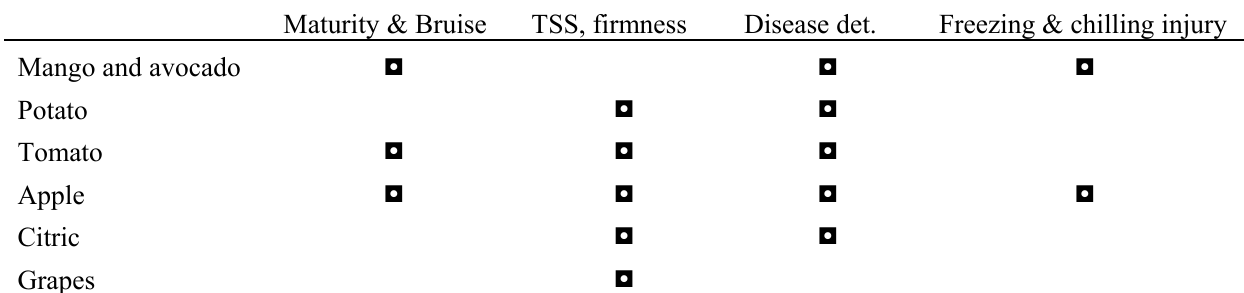
Table 3. Post-harvest operations where sensing is applied.